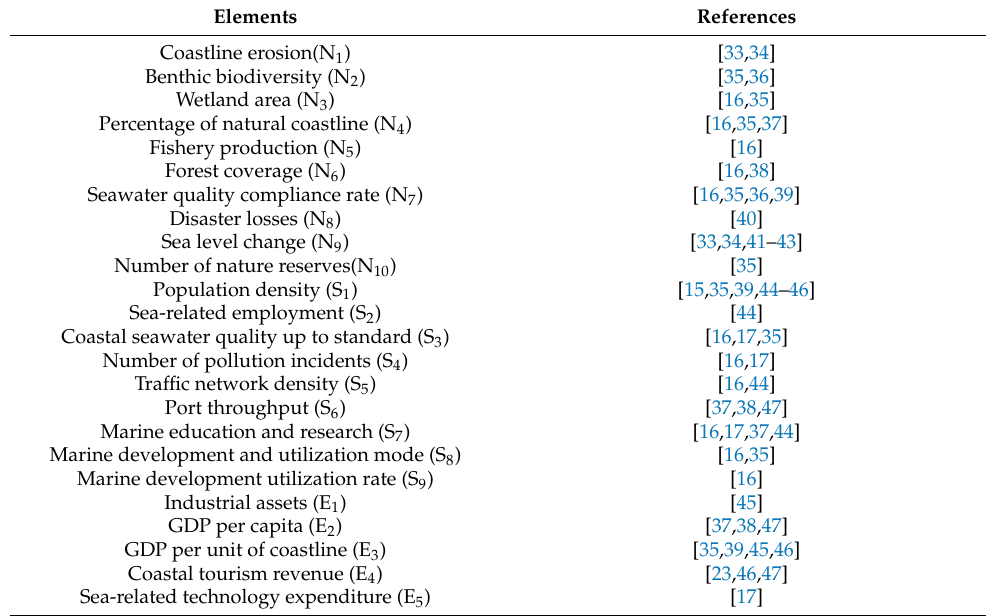
Table 2. Collection of factors influencing coastal zone